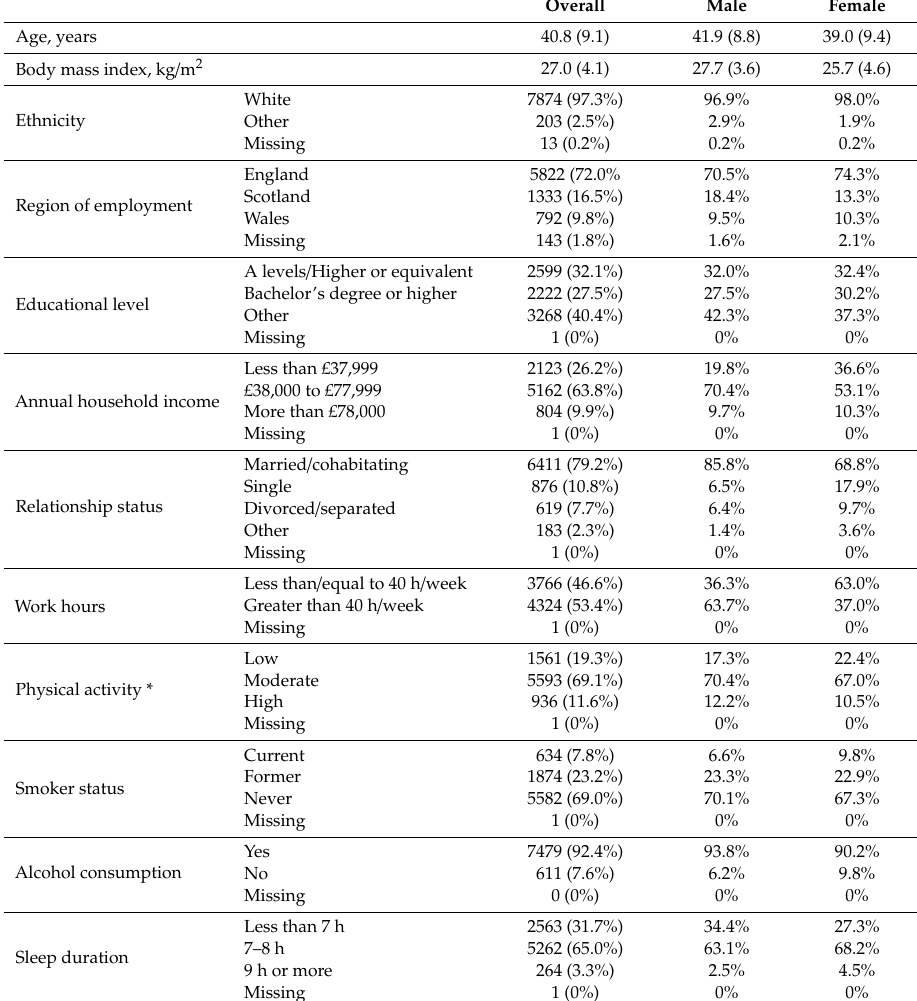
* Scored using the IPAQ Scoring Guidelines for vigorous, moderate and low activity